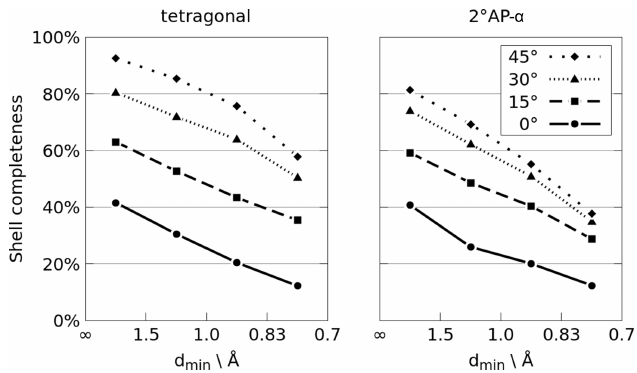
Figure 5 Average shell completeness for a model tetragonal crystal (left) and 2 (cid:2) AP- (cid:2) (right) as a function of data resolution, assuming Mo K (cid:2) wavelength and 35 (cid:2) opening angle. Different lines indicate topple angles between the (001) direction and the diamond culet normal. The relative increase in completeness is observed mainly at higher resolution, where data have high importance for correct space group determination. In the tetragonal case, tilting the crystal increases completeness fourfold in the highest resolution shell and ‘only’ about twofold in the lowest resolution